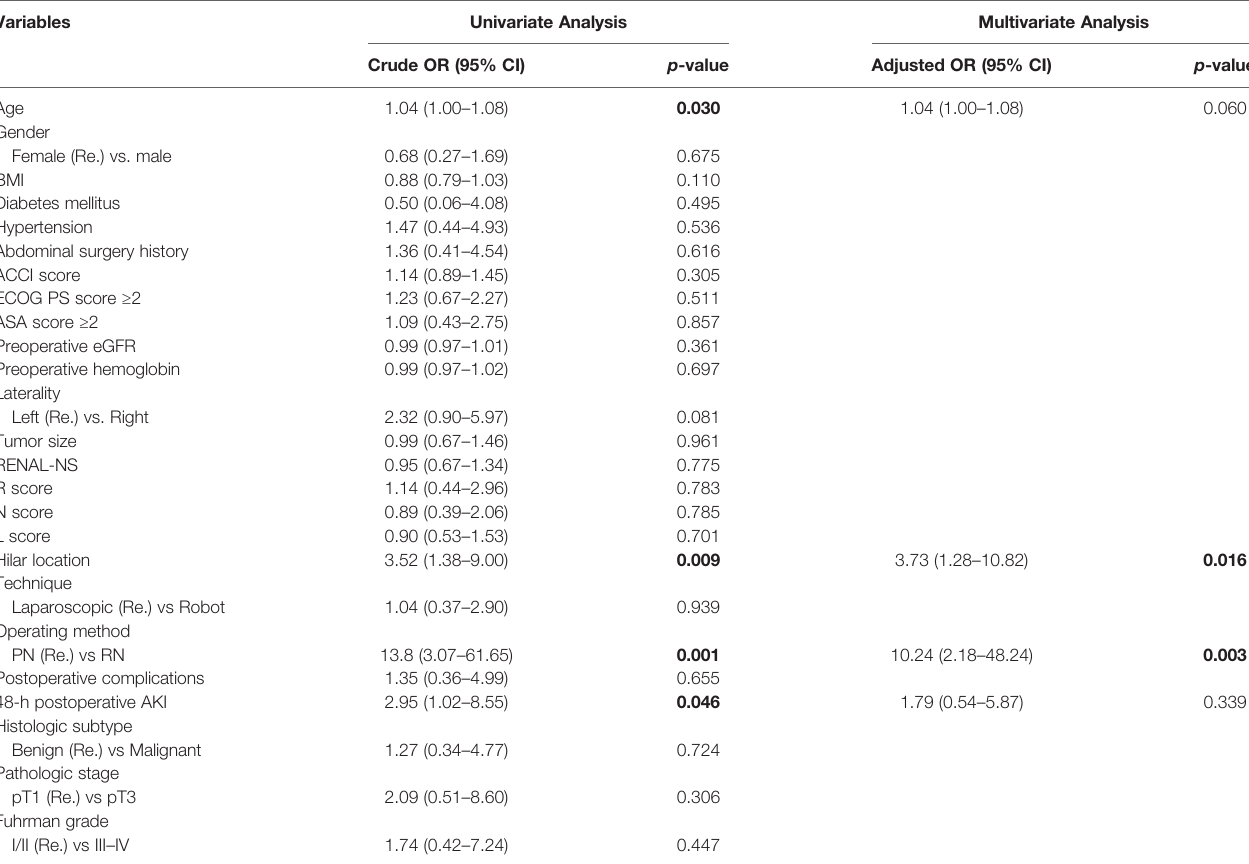
TABLE 5 | Univariate and multivariate Logistic analysis of independent risk factors for new onset CKD stage ≥ II at last